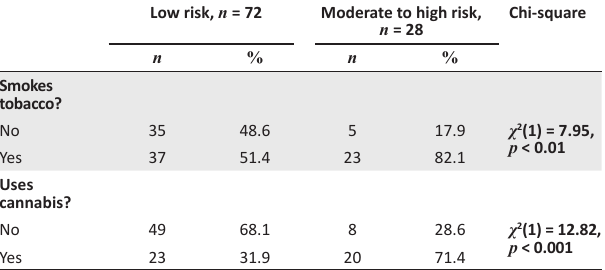
Involvement Screening